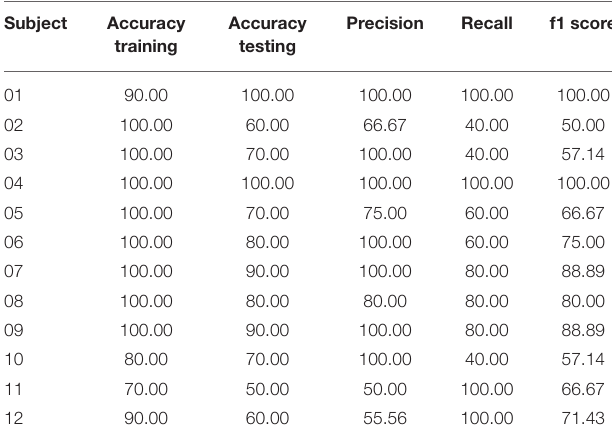
TABLE 1 | Simulator experiment: machine learning results.